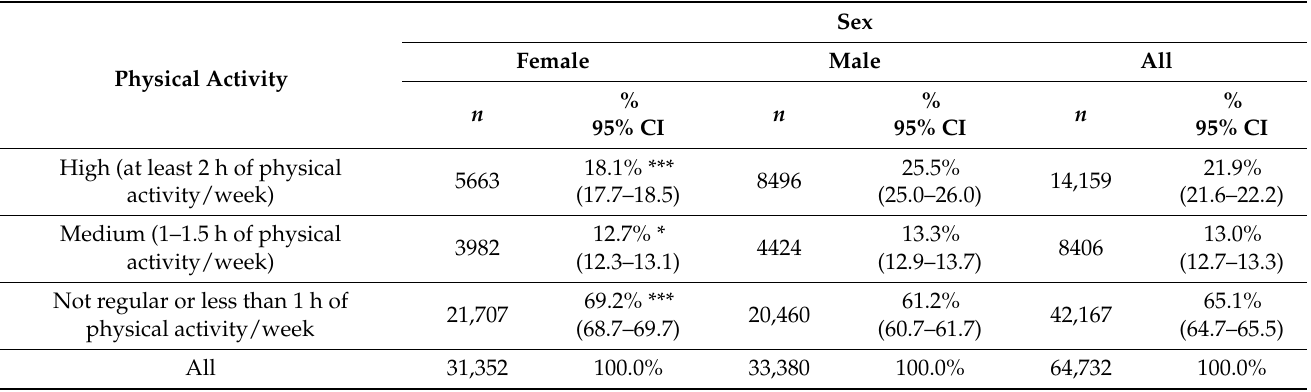
Table 2. Respondents aged 65+ years old according to sex and their level of physical activity.